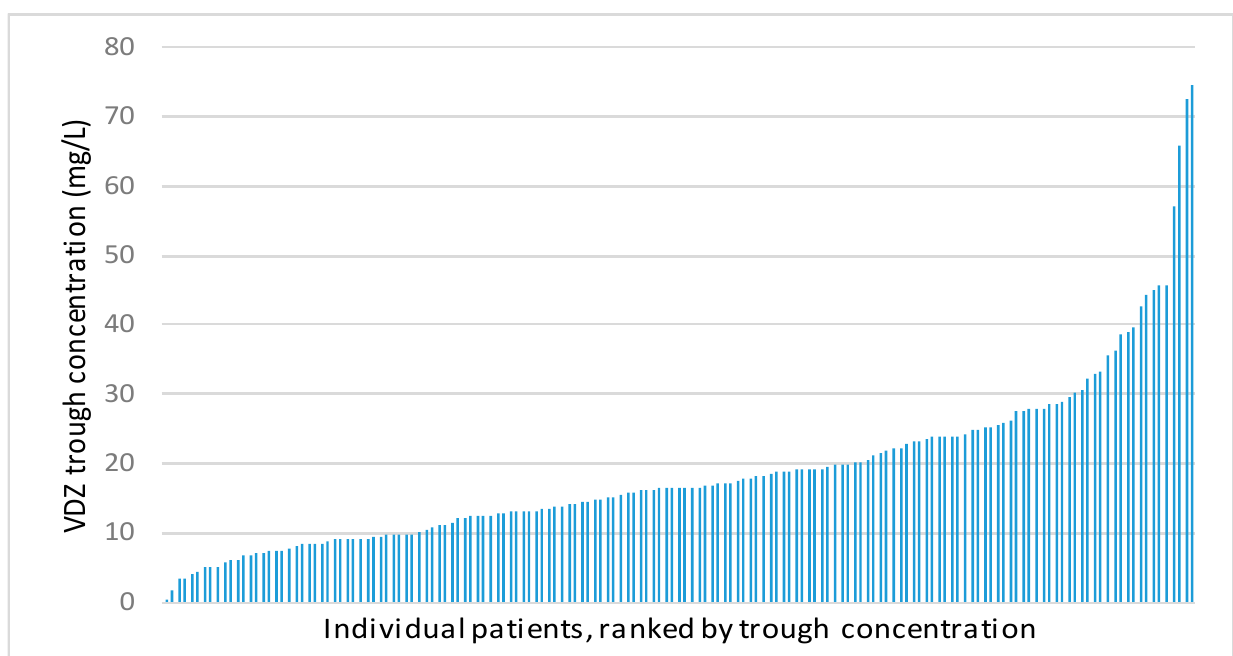
Individual patients, ranked by trough concentration Figure 1. Distribution of vedolizumab trough concentrations in total cohort in mg/L. Figure 1. Distribution of vedolizumab trough concentrations in total cohort in